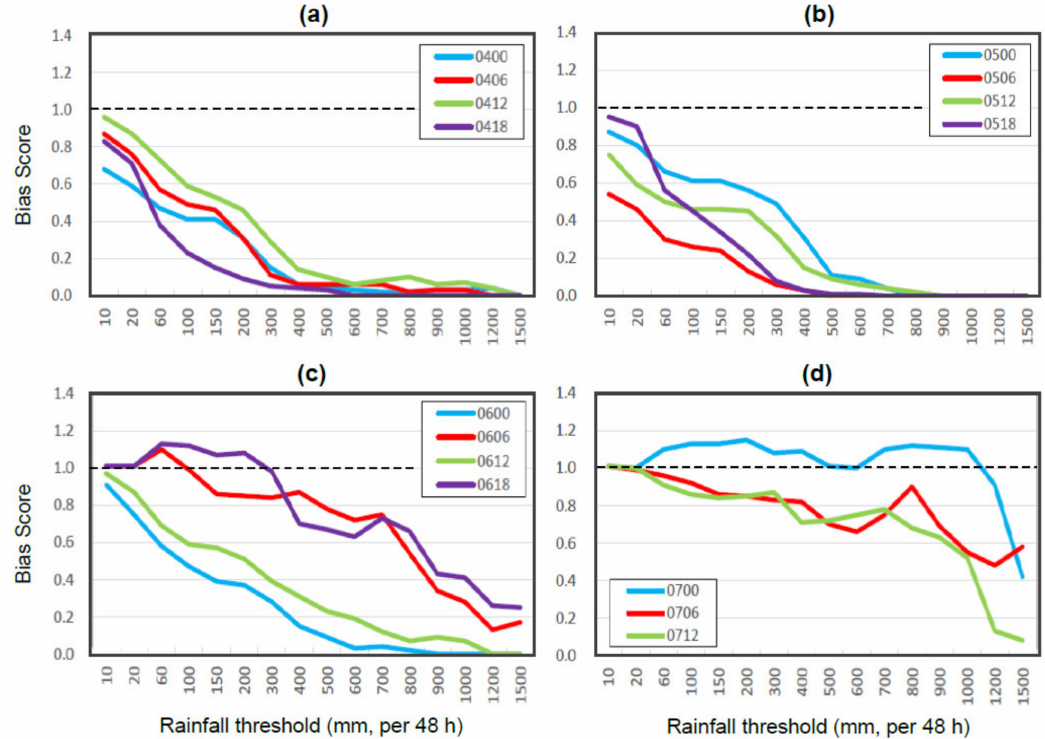
Figure 6. As in Figure 5, except for Bias scores (BSs) from the time-lagged ensemble hindcasts